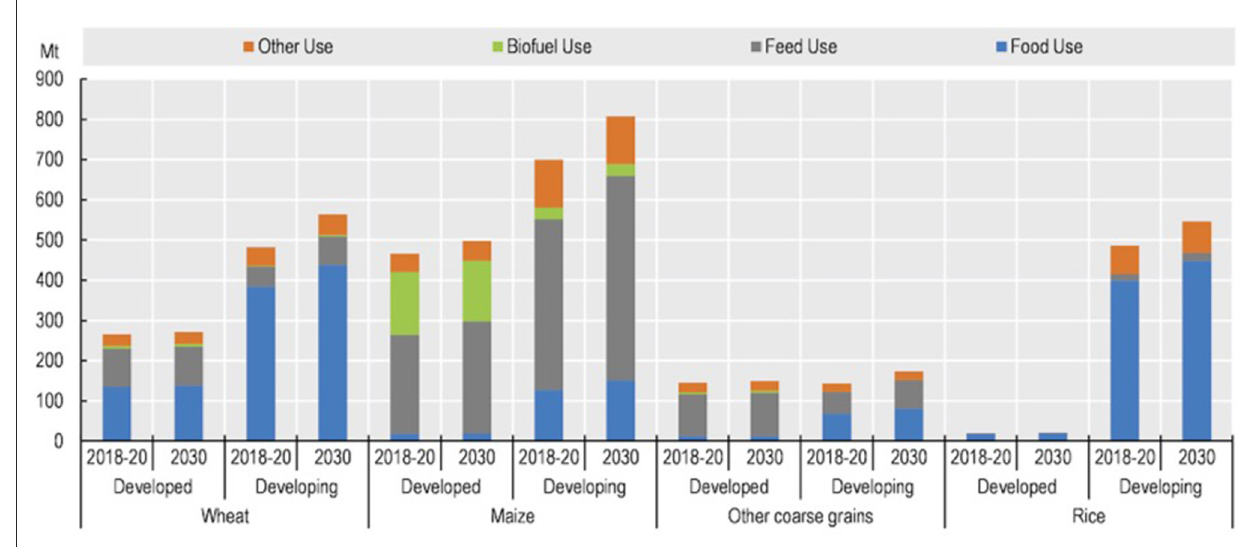
FIGURE4 Cereal use in developed and developing countries (OECD/FAO, 2019) (Figure re-produced with permission from PubRights@oecd.org).